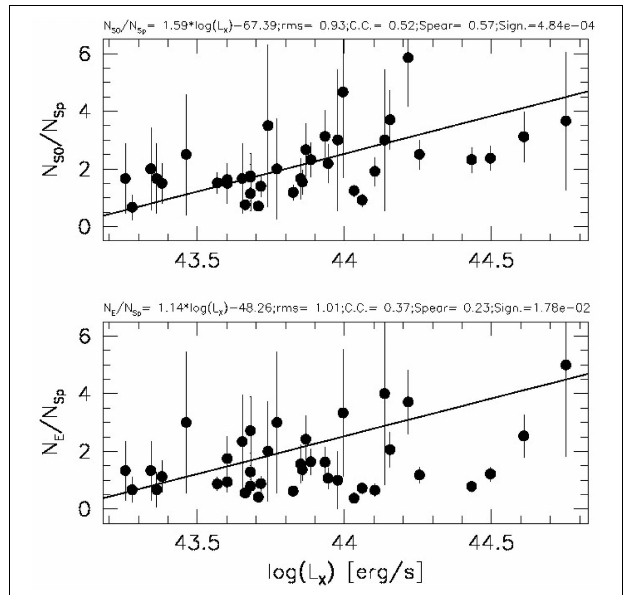
FIGURE 13 | From top to bottom the mass distribution of the WINGS S0 galaxies compared with that of Spirals, E’s and S0’s from the EDisCS